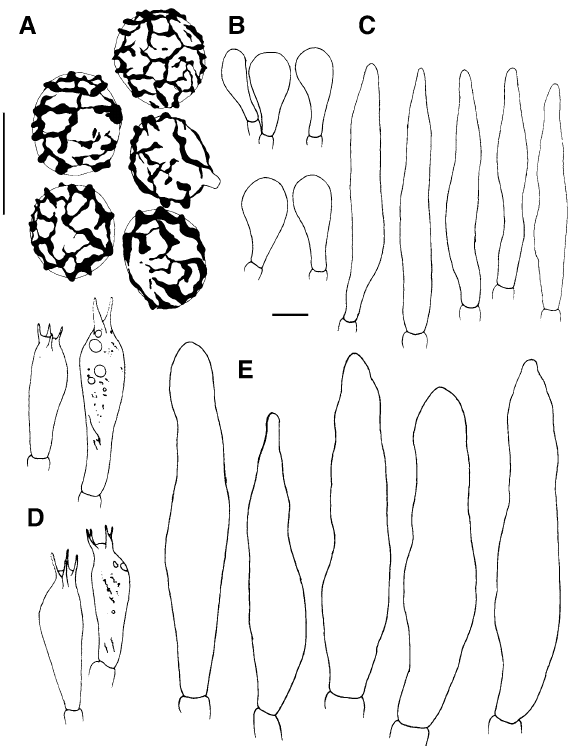
Figure 8. Hymenial elements of Russula luteonana (holotype, BBH41120). ( A ) Spores as seen in Melzer’s reagent. ( B ) Clavate marginal cells. ( C ) Subulate marginal cells. ( D ) Basidia. ( E ) Hymenial cystidia on lamellae sides. Scale bar = 10